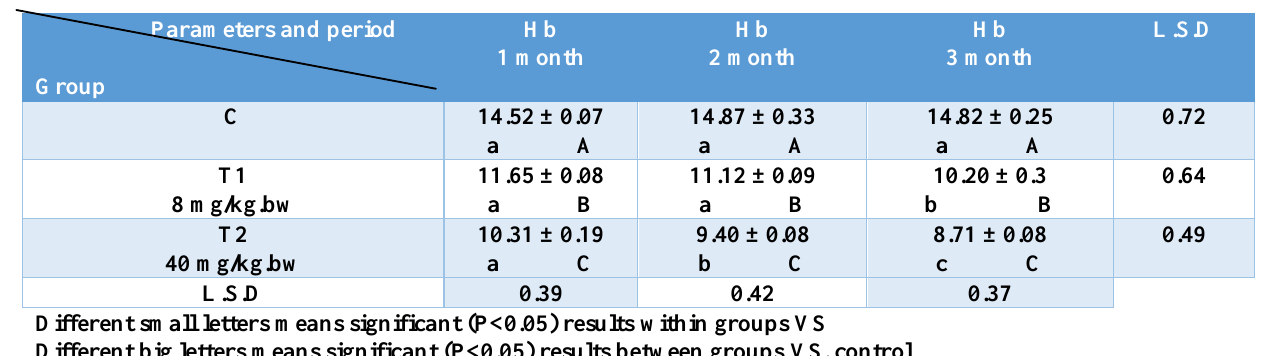
Table, 1: Values of Hb (g/dl) in blood of rats treated with different doses of CuSO4.5H2O